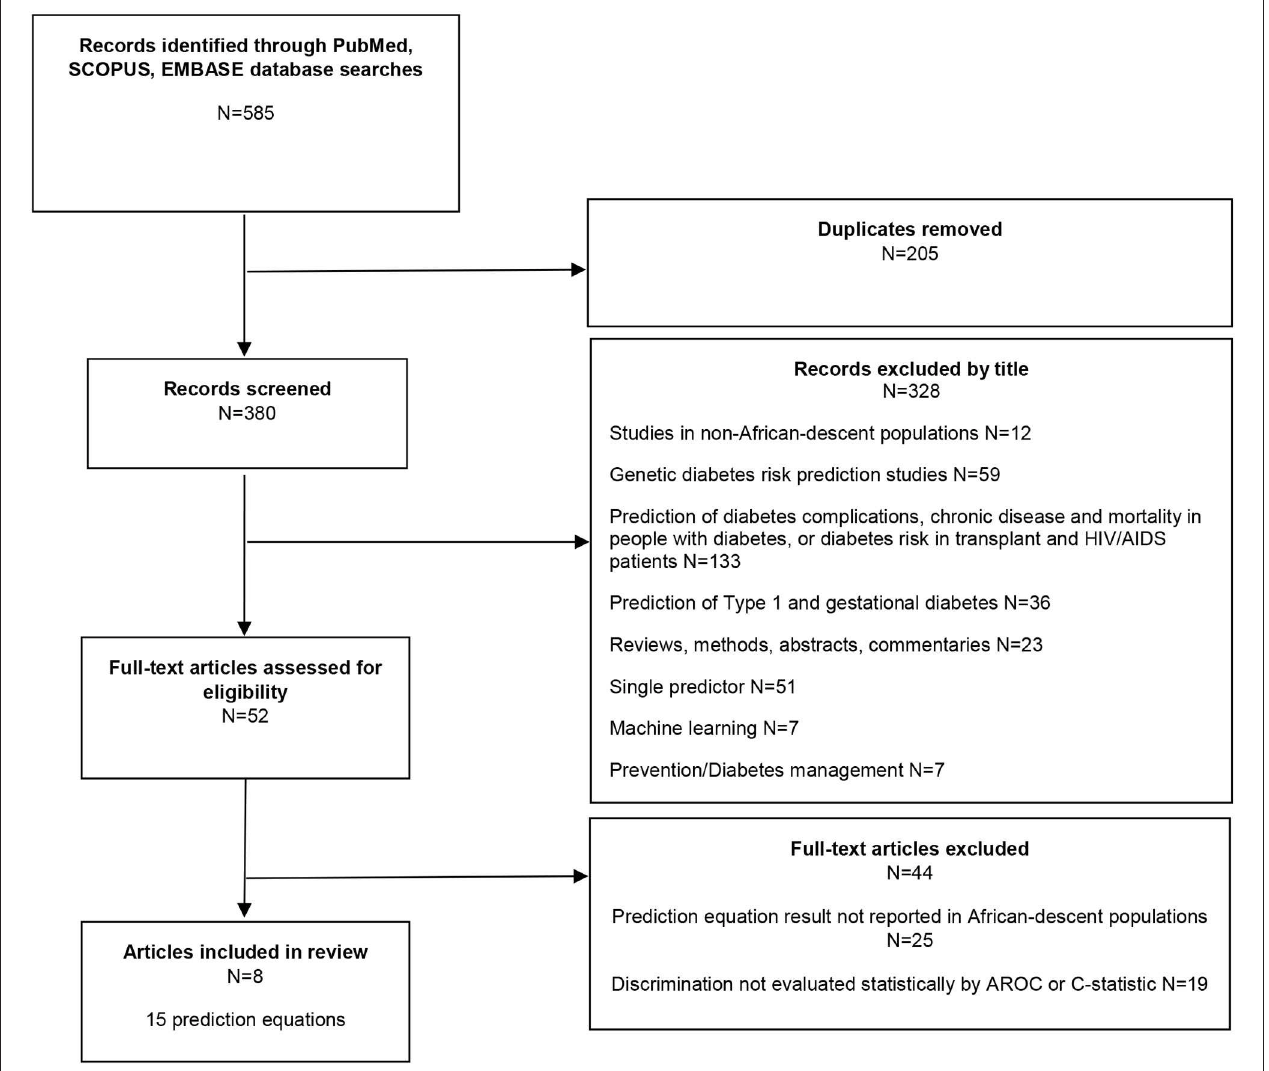
FIGURE 1 | Diabetes prediction equation studies: literature review flowchart, diabetes prediction equations in African descent